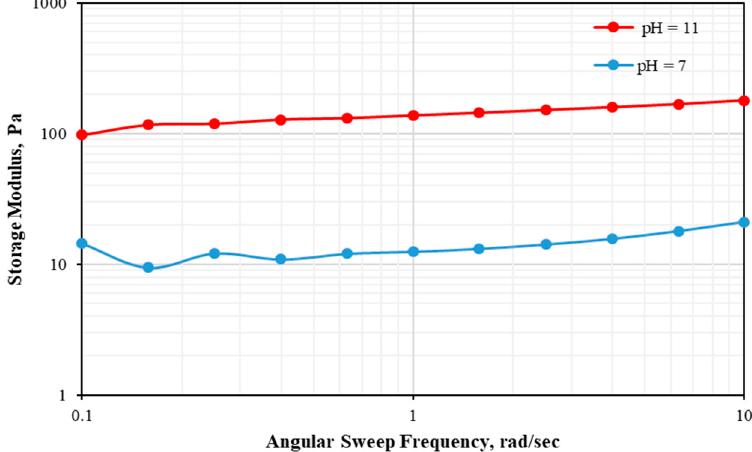
Figure 11. E ff ect of pH on the storage modulus of gels composed of 3.5% CuAc / 9% PaM (25 ◦